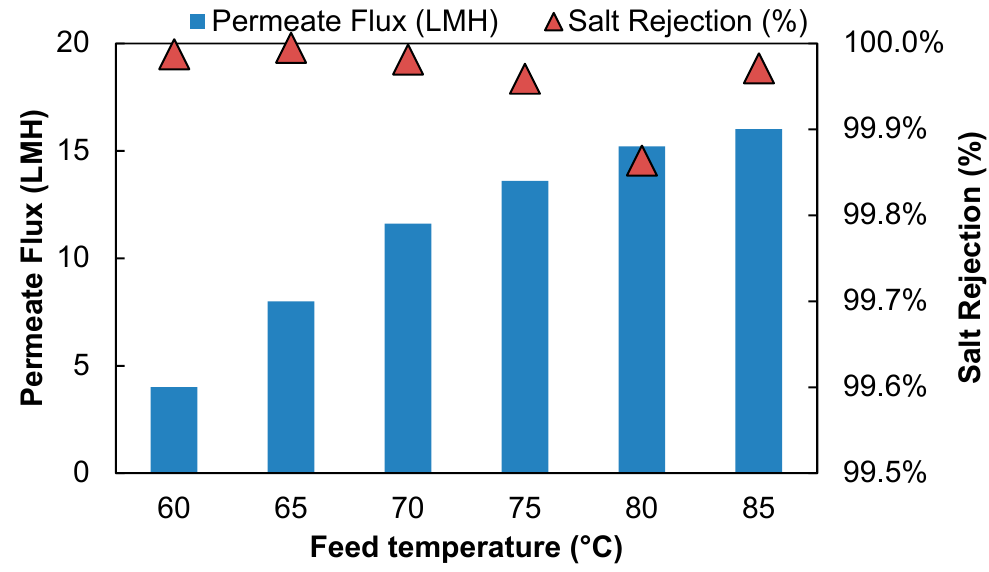
Figure 3. The impact of feed temperature on PVD system performance with cross-flow Reynolds number of 4800, feed NaCl concentration of 15 g / L and permeate vacuum of 0.85 bar. The blue bars represent permeate flux ( y -axis on the left) and the red triangle dots represent salt rejection ( y -axis on the right). Table 1. Apparent diffusion coefficient of water at different temperatures.